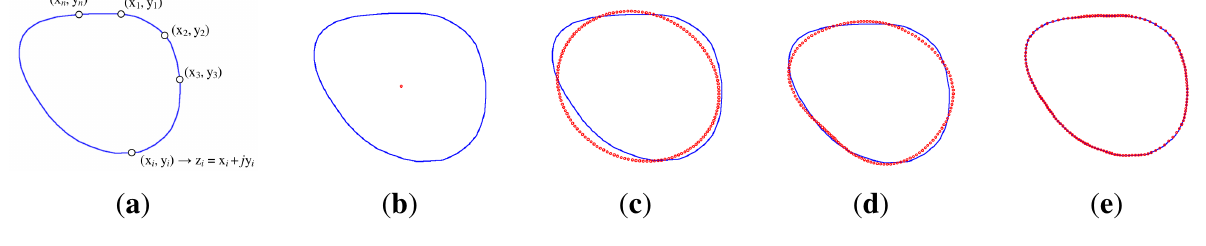
Figure 2. Reconstruction of the rim contour using Fourier descriptors . ( a ) Initial